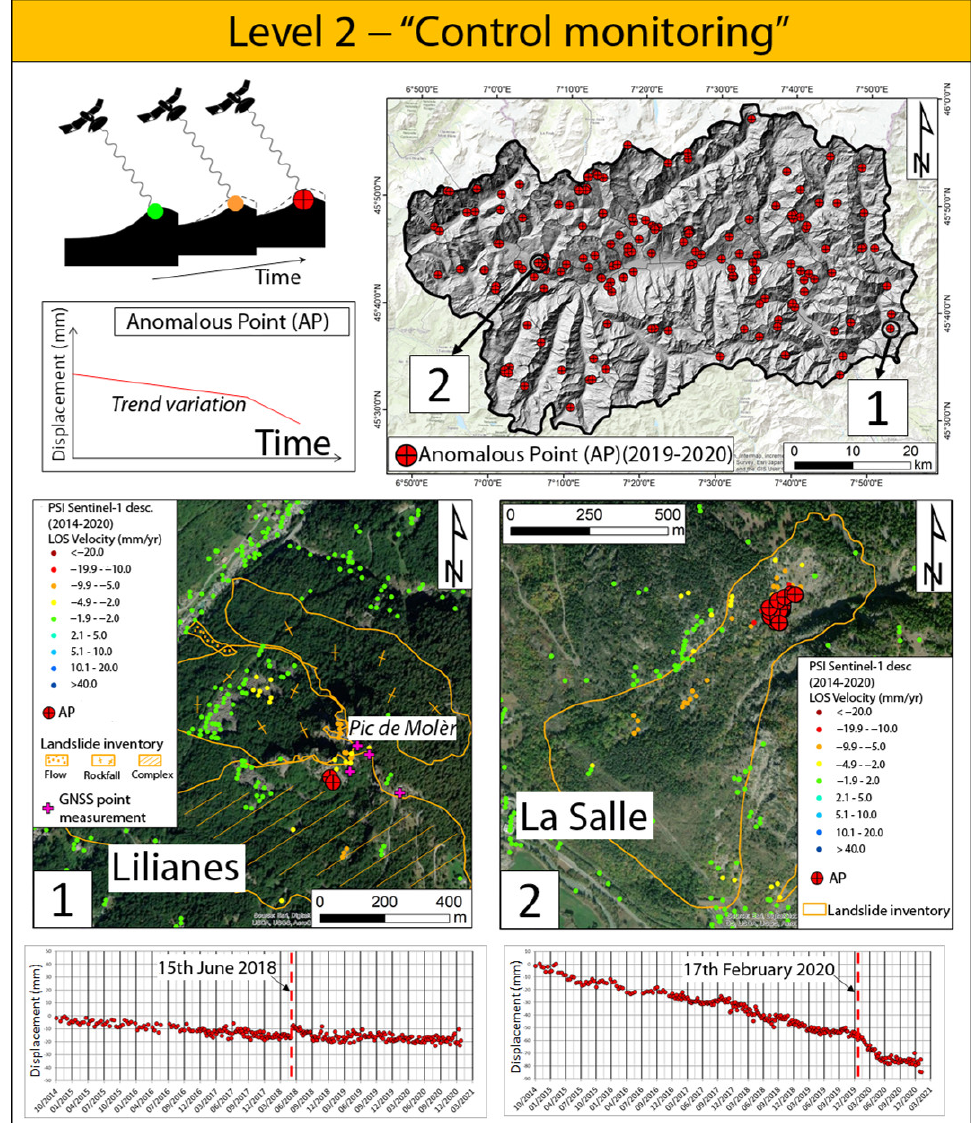
Figure 3. Level 2—“Control monitoring”: Concept of ”PS monitoring” ( top-left box ); Distribution of Anomalous Point targets (APs) in 2019–2020 within PS monitoring activity over the VAR ( top-right box ); two examples of APs, locations labeled ( 1 ) and ( 2 ), are shown in the top-right box ( lower boxes